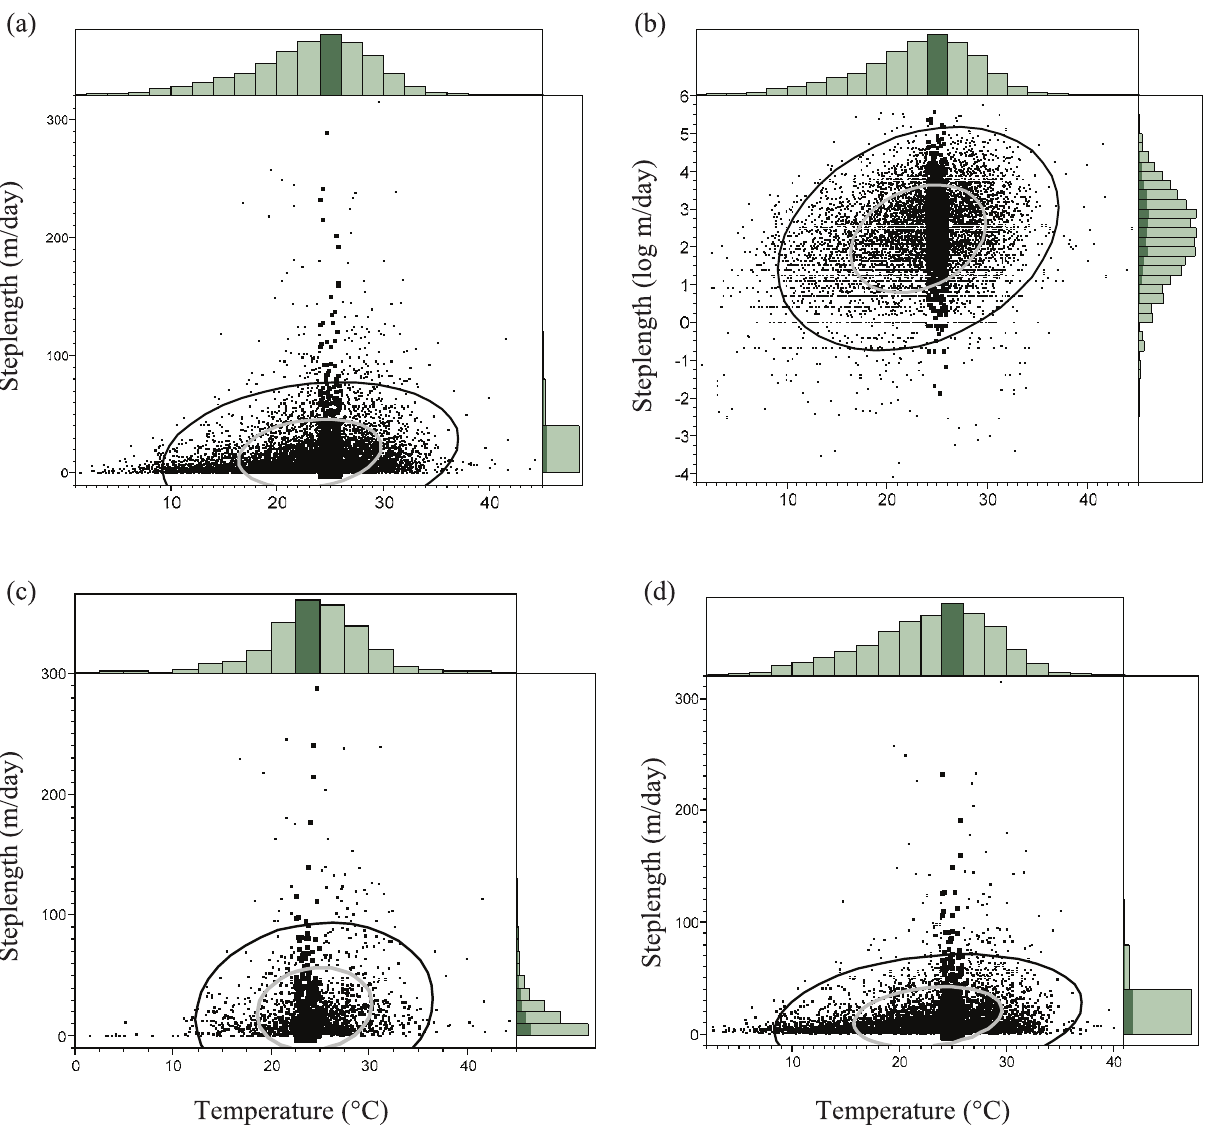
Figure 2. Thermal Optima. Scatter plot of daily distances traveled by eastern box turtles (steplengths; y-axes) by ground temperature (T g in u C; x- axes). All 2007–10 steplengths (in meters per day) by ground temperature (a.) and the log-transformed steplength by ground temperature (b.). Pre- harvest (2007–08) steplength in meters per day by ground temperature (c.) and post-harvest (2009–10; d.). Plots show 95% (black ellipse) and 50% (grey ellipse) density ellipses around points and histogram densities along plot boarders. Darkened areas represent the peak of activity temperatures (22–26 u C; thermal optimum) in these data.